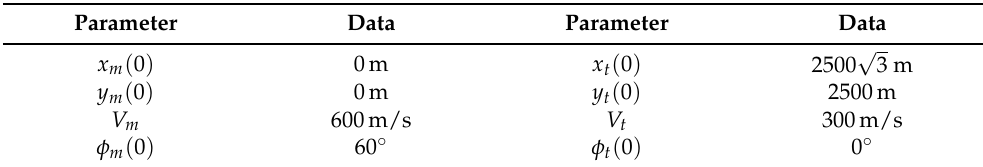
Table 1. Some constants and initial conditions for the missile and the target in the simulations with differential fractional orders.